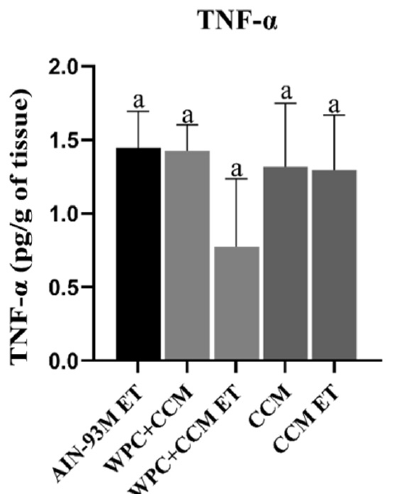
Figure 4. TNF- α profile in muscle using the cytometric bead array kit. AIN-93M: group not submitted to ET that received a standard diet; AIN-93M ET: group submitted to the exhaustion test that received a standard diet; WPC + CCM: group not submitted to ET that received curcumin-added whey protein concentrate; WPC + CCM ET: group submitted to the exhaustion test that received curcumin-added whey protein concentrate; CCM: group not submitted to ET that received curcumin; CCM ET: group submitted to the exhaustion test that received curcumin; ET: exhaustion test. According to ANOVA, different lowercase letters indicate significant mean differences among the groups, followed by the Newman–Keuls test, at 5% probability. Same lowercase letters indicate that there was no significant mean difference among the groups. Data expressed as mean ± standard deviation.